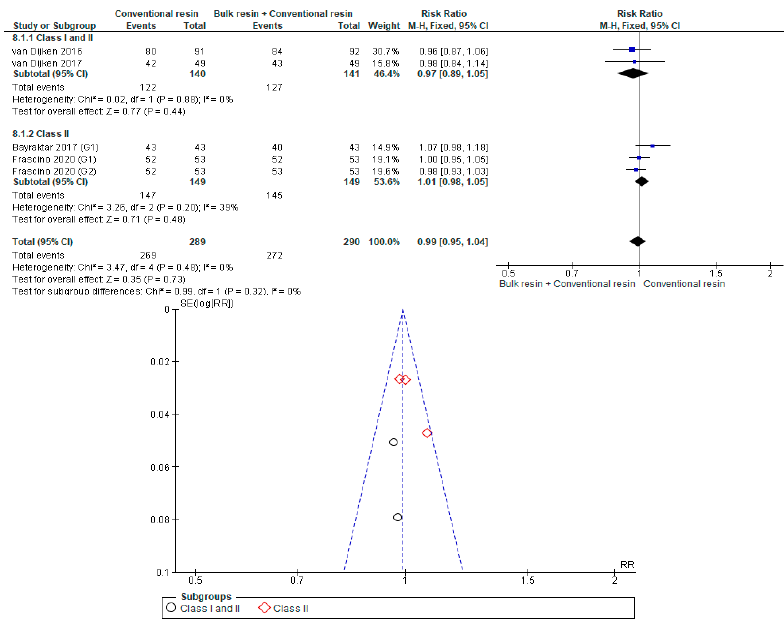
Figure A35. Proper Anatomical Form: Conventional Resin versus Bulk Resin Covered with Conventional Resin According to Type of Restoration.